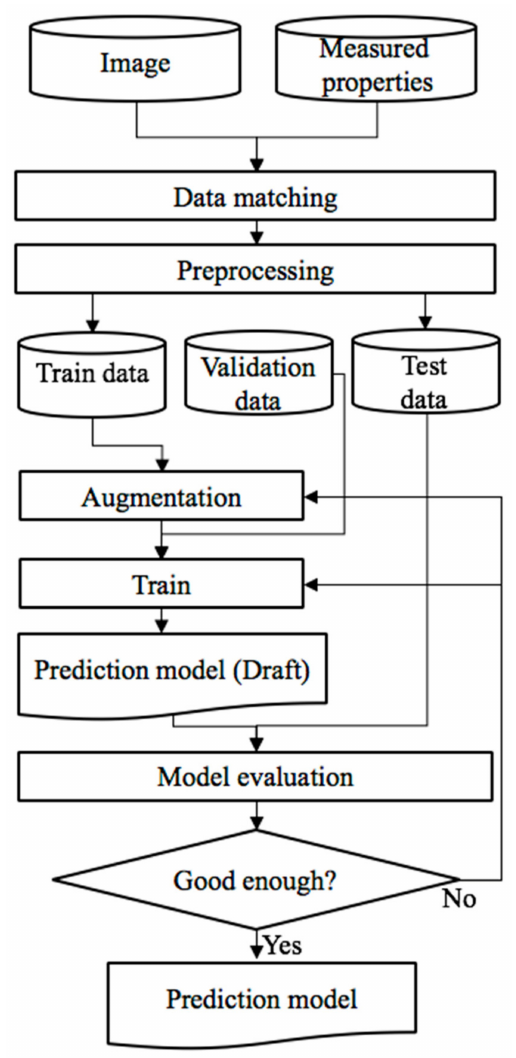
Figure 4. Flow chart of the proposed deep learning